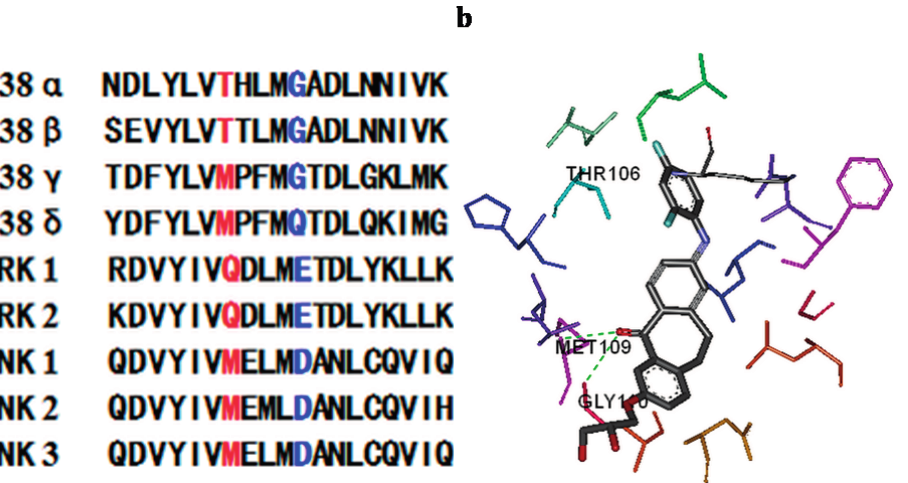
Figure 1. ( a ) Sequence alignment of human MAP kinases (residues 100–118) and related kinase: both Thr106 ( red ) and Gly110 ( blue ) are unique in p 38 α / β , and allow for close interactions of the proteins with the p 38 α inhibitors [13]; ( b ) Schematic of the binding mode of 2-(2,4-difluoro-phenylamino)-7-(2 R ,3-dihydroxy-propoxy)-10,11-dihydro-dibenzo[ a , d ] cyclohepten-5-one (Skepinone-L, PDB ID 3QUE) with p 38 α MAP kinase